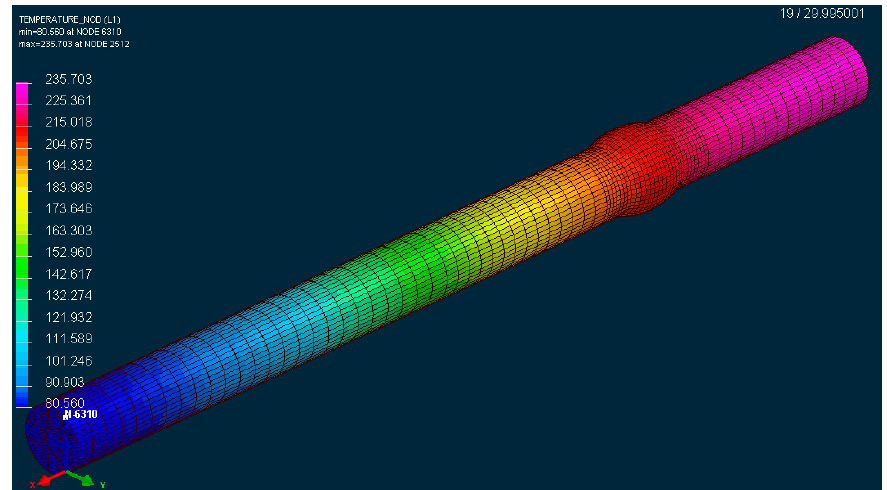
Figure 16. The simulation of the thermal gradient of the material EN AW 6063.T66 welded by the TIG technology with implementing the predefined welding parameters in the period t = 20 s since the end of the welding procedure.